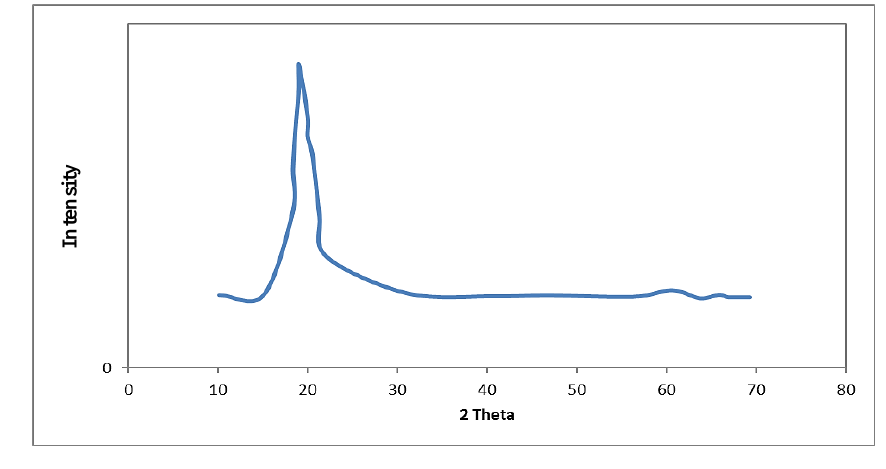
Figure 1. The XRD pattern of CNW.